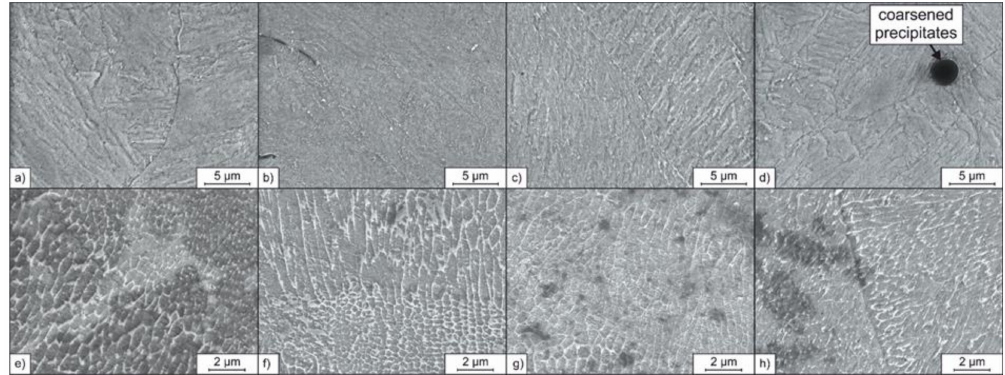
Figure 14. SEM micrographs of the PBF-LB/M densified and heat-treated samples: ( a ) 1.2709, ( b ) SiC/1.2709, ( c ) FLG/1.2709, ( d ) IOB/1.2709 solution annealed and aged; ( e ) 1.2709, ( f ) SiC/1.2709, ( g ) FLG/1.2709, ( h ) IOB/1.2709 aged